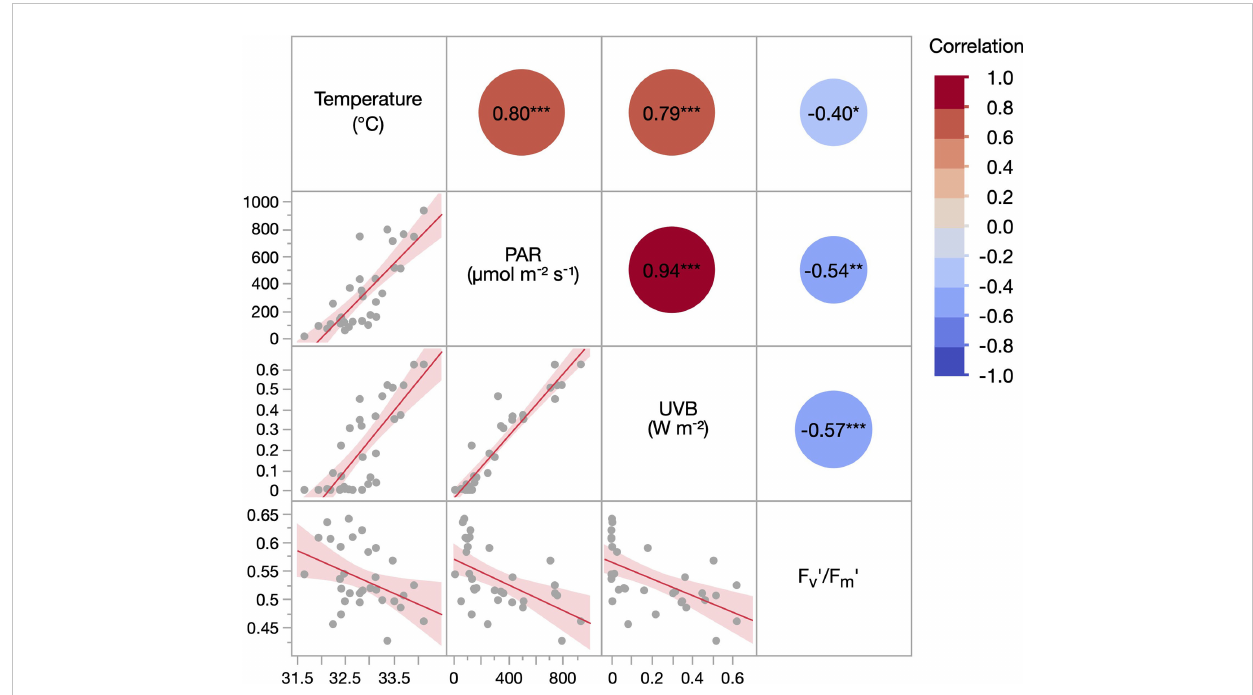
FIGURE 6 Correlation matrix of the environmental parameters water temperature, PAR, and UVB, as well as the effective quantum yield ( F v ’ / F m ’ ) of Pocillopora verrucosa colonies. Measurements were performed in 0.5 – 8.0m at Al Fahal reef in the central Red Sea between 15 th July – 09 th August 2018. Temperature, PAR, and UVB values are averages of the 10 minutes before each F v ’ / F m ’ measurement. The red line and shaded area represent the correlation line and 95% CIs, respectively. Values in the circles indicate the Pearson correlation coef fi cient (r). Asterisks show p < 0.05 (*), p < 0.01 (**) and p < 0.001